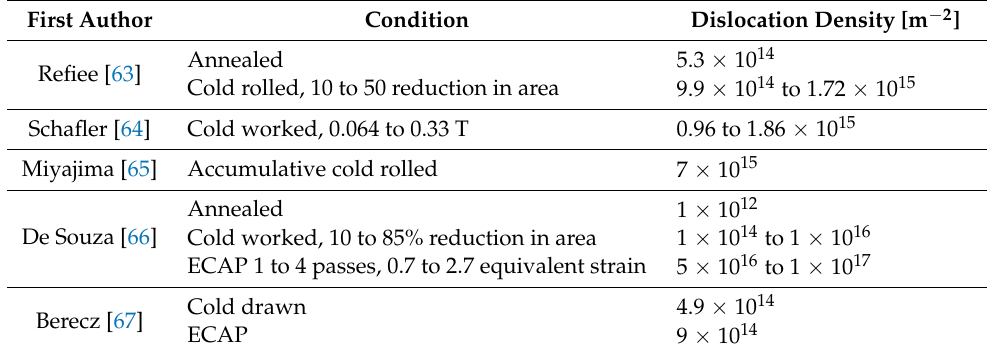
Table 2. Literature data for the dislocation density present in copper for different strain